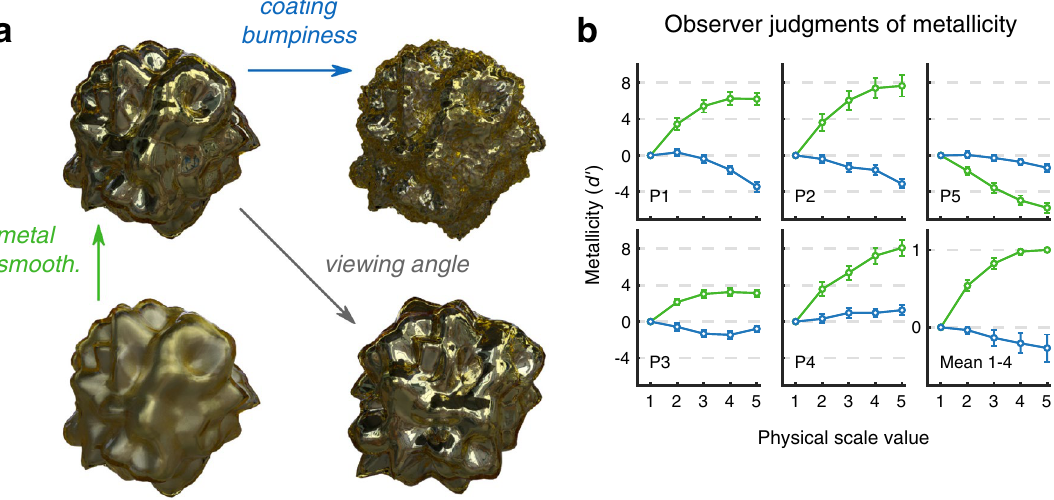
Figure 1. Conjoint measurement analysis of the judgment of metallicity by observers. ( a ) The parameter space used in experiments. Stimuli were physically-based rendered computer graphics of a composite coated metal object. Smoothness of the metal, and bumpiness of the coating, vary from zero to a physically plausible upper limit. The objects could be viewed from eight possible rotations around the z-axis. ( b ) Conjoint measurement plots for individual observers. Plots show the contributions of metal smoothness (green) and coating bumpiness (blue) to judgments of metallicity. Error bars for individual participants show 95% confidence intervals